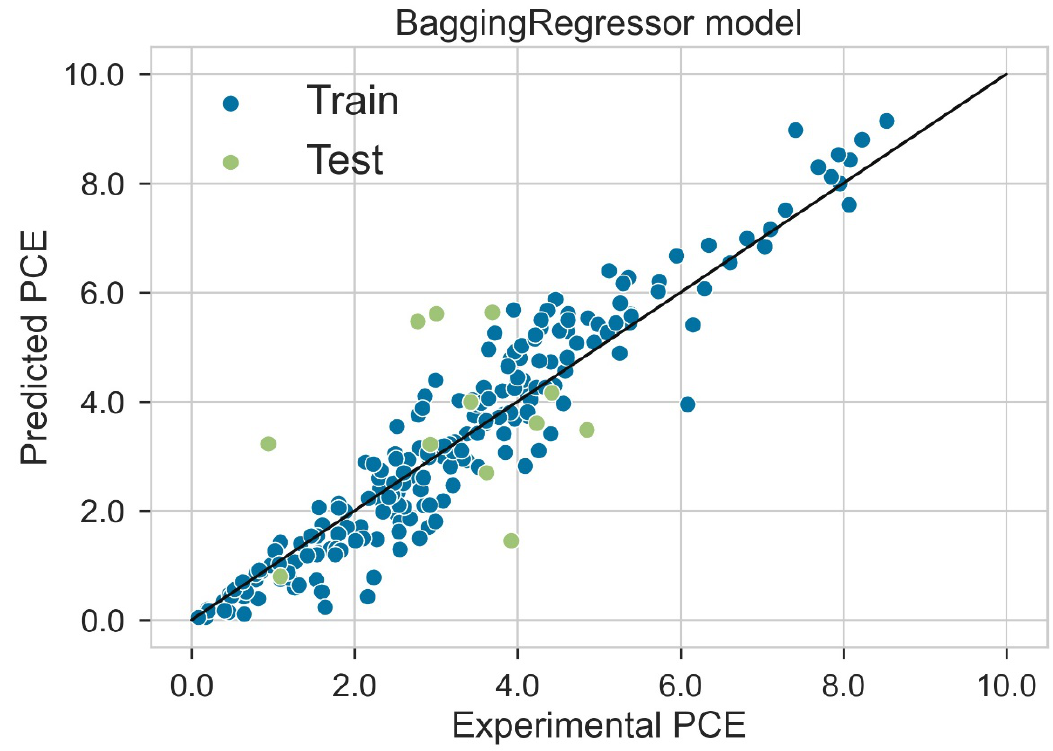
Figure 10. Scatter plot comparing experimental PCE and predicted PCE (bagging model).